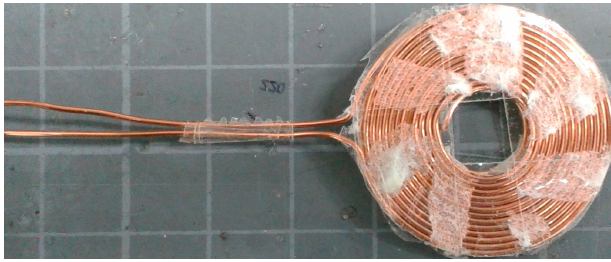
Figure 10. The Single coil evaluation path.